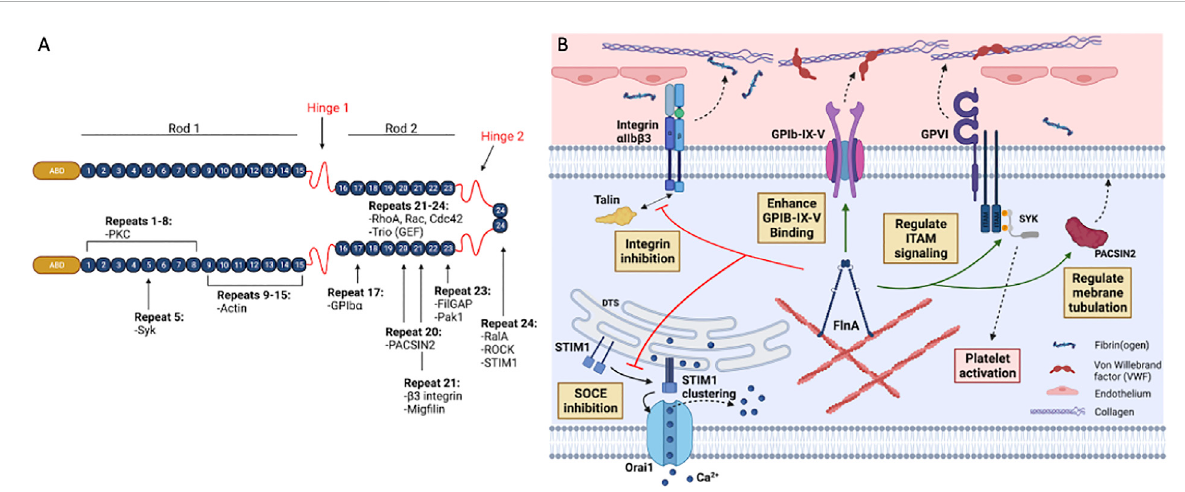
FIGURE 1 Structure and binding partners of FLNA. (A) FLNA is a 280 kDa homodimer consisting of an actin-binding domain (ABD) at the N-terminus, followed by 24 immunoglobulin (Ig)-like repeat domains folded into β -sheets (numbered 1 – 24). Two hinge domains, one at Ig repeat 15 – 16 and another at 23 – 24, separate the Ig domains into two different rod regions: rod one and rod 2. Rod one consists of Ig repeats 1 – 15, and rod two consists of Ig repeats 16 – 23. Dimerization occurs through the interaction of repeat 24. FLNA interacts with many receptors and signaling molecules through its 24 Ig repeats. (B) In platelets, the store-operated calcium entry (SOCE) is regulated by the interaction between STIM1 and Orai1. Upon depletion of Ca 2+ storage, STIM1 undergoes a conformational change and multimerizes on the dense tubular system (DTS) membrane. Consequently, STIM1 clusters initiate the assembly of Orai1 subunits in the plasma membrane, forming a Ca 2+ channel which leads to the in fl ux of extracellular Ca 2+ . FLNA downregulates SOCE function by directly interacting with STIM1 in the actin cytoskeleton, thereby abolishing the STIM1- Orai1 interaction. In resting platelets, FLNA has been proposed to constitutively associate with integrin β 3 cytoplasmic tail (CT) through its Ig repeat 21. This association blocks the interaction between the β 3 CT and talin or kindlin-3, thereby inhibiting integrin α IIb β 3 activation. GPIb-IX-V mediates adhesion of platelets to von Willebrand factor(VWF)upon endothelial injuries. FLNA constitutively interacts with GPIb-IX-V and enhances its binding to VWF. This interaction involves FLNA Ig repeat 17 to the GPIb α CT of GPIb-IX-V. FLNA also positively regulates ITAM- and ITAM-like-containing receptor signaling in platelets by interacting with Spleen tyrosine kinase (Syk). This interaction is essential for GPVI receptor signaling, which is an important pathway for collagen-mediated platelet adhesion and activation. FLNA Ig repeat 20 interacts with the F-BAR protein PACSIN2 to